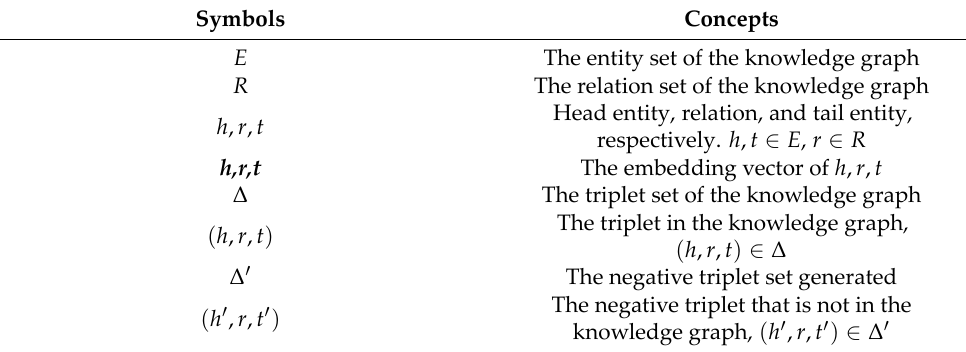
Table 1. The general concepts and symbols in this paper. Symbols Concepts E The entity set of the knowledge graph R The relation set of the knowledge graph Head entity, relation, and tail entity, h , r , t respectively. h , t ∈ E , r ∈ R h,r,t The embedding vector of h , r , t ∆ The triplet set of the knowledge graph The triplet in the knowledge graph, ( h , r , t ) ( h , r , t ) ∈ ∆ ∆ ′ The negative triplet set generated The negative triplet that is not in the ( h ′ , r , t ′ ) ′ ′ ) ∈ ∆ , r , t knowledge graph, ( h